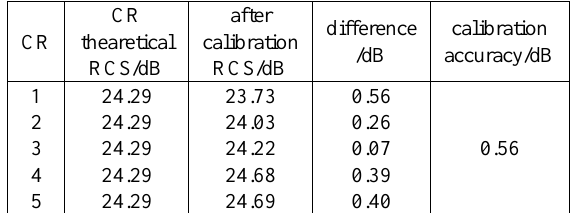
Table.6 Integral method Absolute Calibration Accuracy Verification Table